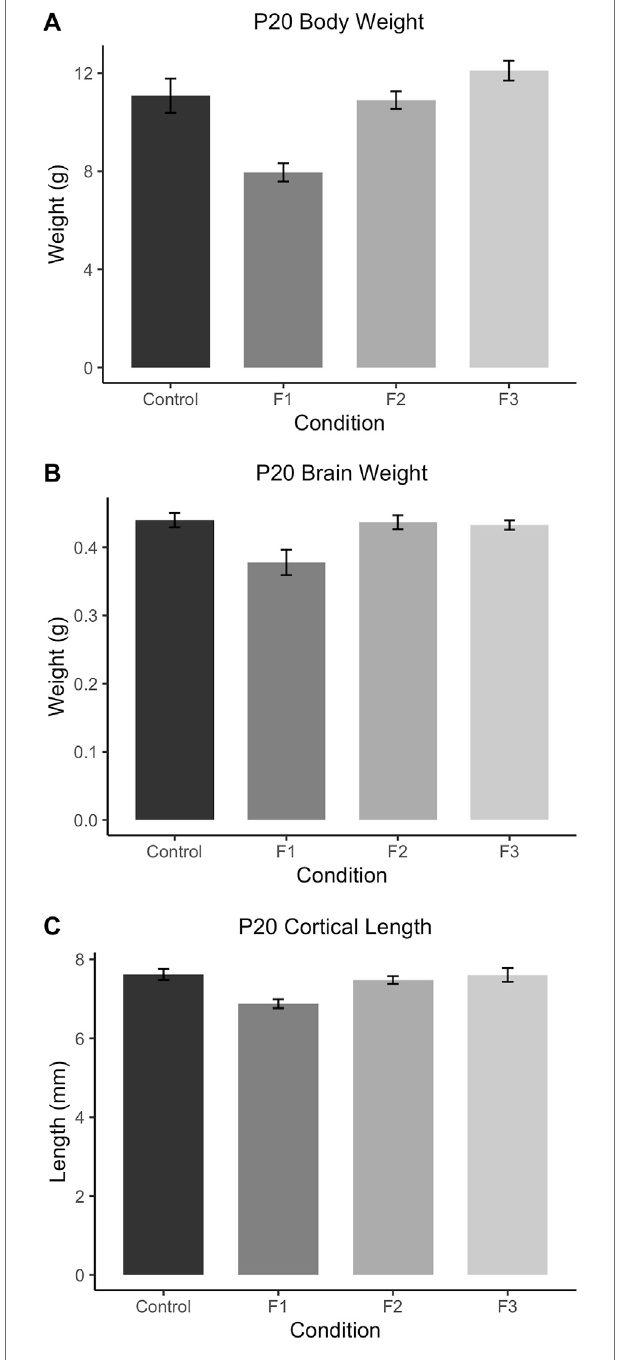
FIGURE 3 | Gross body and brain measurements in P20 mice. (A) F1 mice weigh signi fi cantly less than controls at P20. P20 F1 mice also have signi fi cantlydecreasedbrainweights (B) andcorticallengths (C) compared to controls.